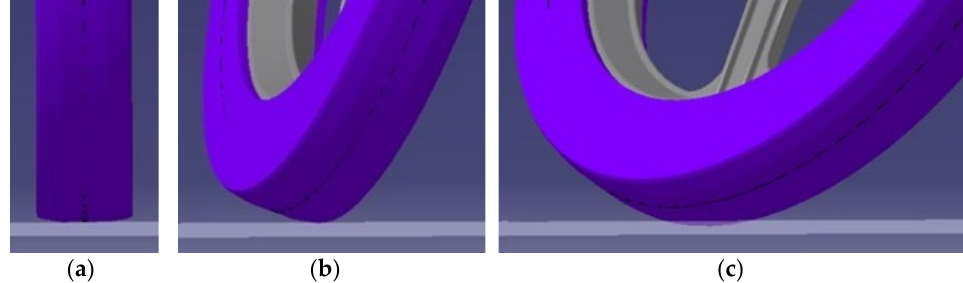
Figure 6. Position of the modified tire casing relative to the reference height when the steering wheel is turned at: ( a ) 0°; ( b ) 60°; ( c ) 90°.